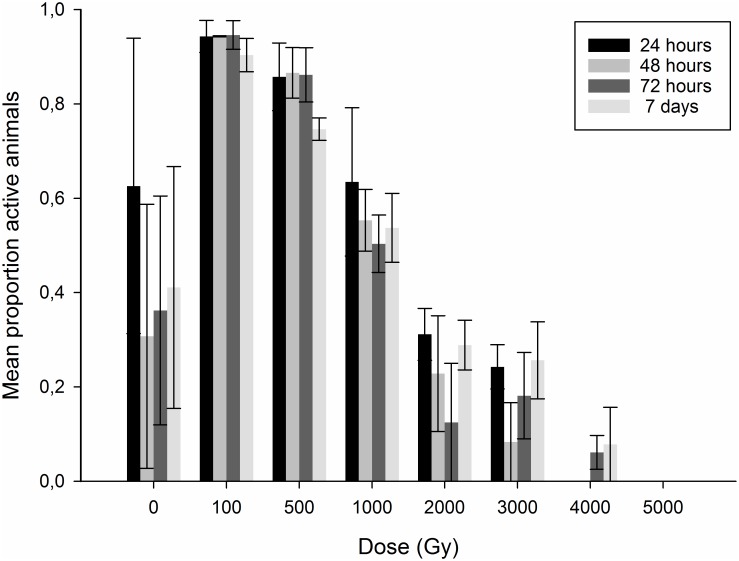
Mean proportion of adult Echiniscoides sigismundi showing activity after exposure to different doses of gamma radiation.The figure shows estimates from four different time points after irradiation, from 24h to 7 days. Error bars represent standard errors of the mean from 3 repeats, each with approx. 20 animals.